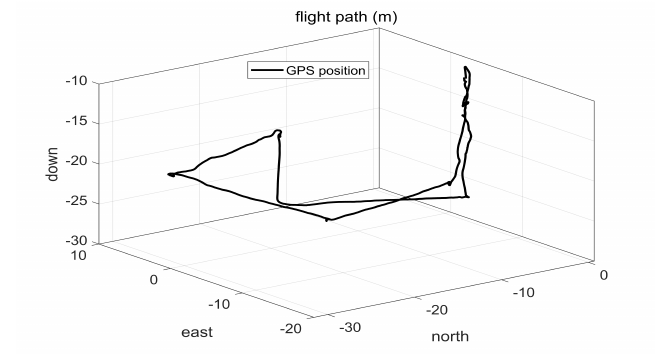
Figure 11. UAV flight